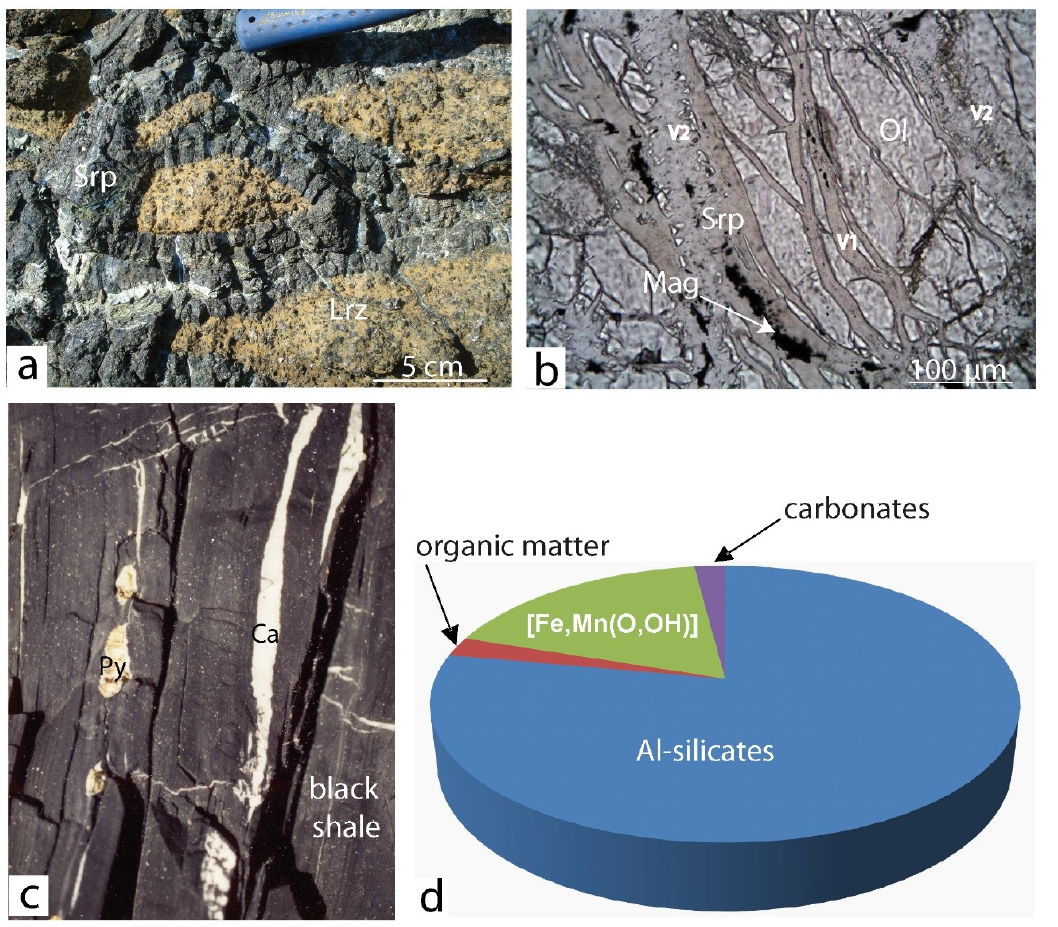
Figure 9. Potential geological sources of chromium (Cr) and vanadium (V) necessary for emerald formation in mafic-ultramafic rocks and black shales: ( a ) A lherzolite (Lrz) that is transformed into serpentinite (Srp), region of Montemaggiore on the Corsican cape, France; ( b ) Photomicrograph (plane polarized light) of an antigorite vein (V2) cross cutting lizardite veins (V1) and olivine (Ol). Fine-grained magnetite (Mag) is present in the centre of V1; V2 boundaries contain minute secondary olivine grains. Photo: B. Debret; ( c ) Colombian black shale crosscut by pyrite (Py) -bearing calcite (Ca) veinlets from the Coscuez mine. Photograph: G. Giuliani; ( d ) Pie diagram representation of the concentration (in %) and relative distribution of beryllium (Be) between the different phases extracted from a black shale containing 4 ppm of 9 Be, Coscuez mine [54]. OM: Organic matter; [Fe,Mn(O,OH)] = oxy-hydroxides of iron and